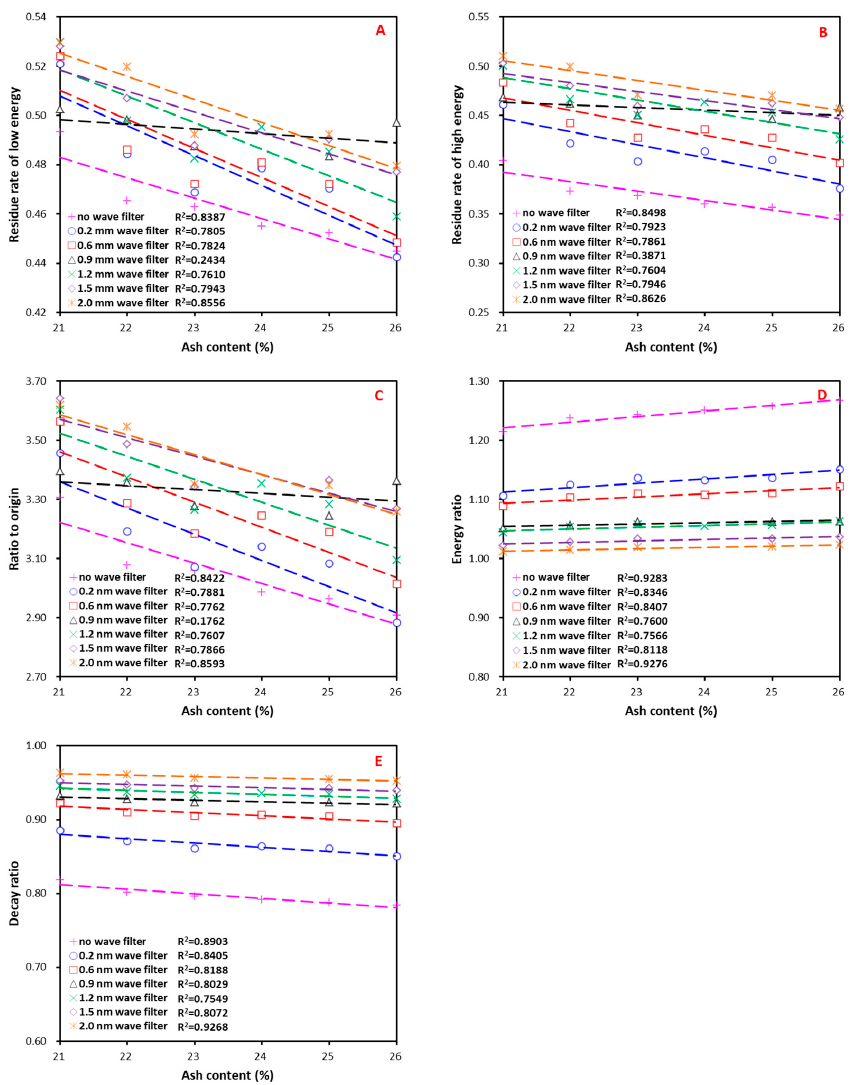
Figure 4. The relationship between ash content and characteristic parameters ( A ): residue rate of low energy; ( B ): residue rate of high energy; ( C ): ratio to origin; ( D ): energy ratio; ( E ): decay ratio with wave filter of different thickness.